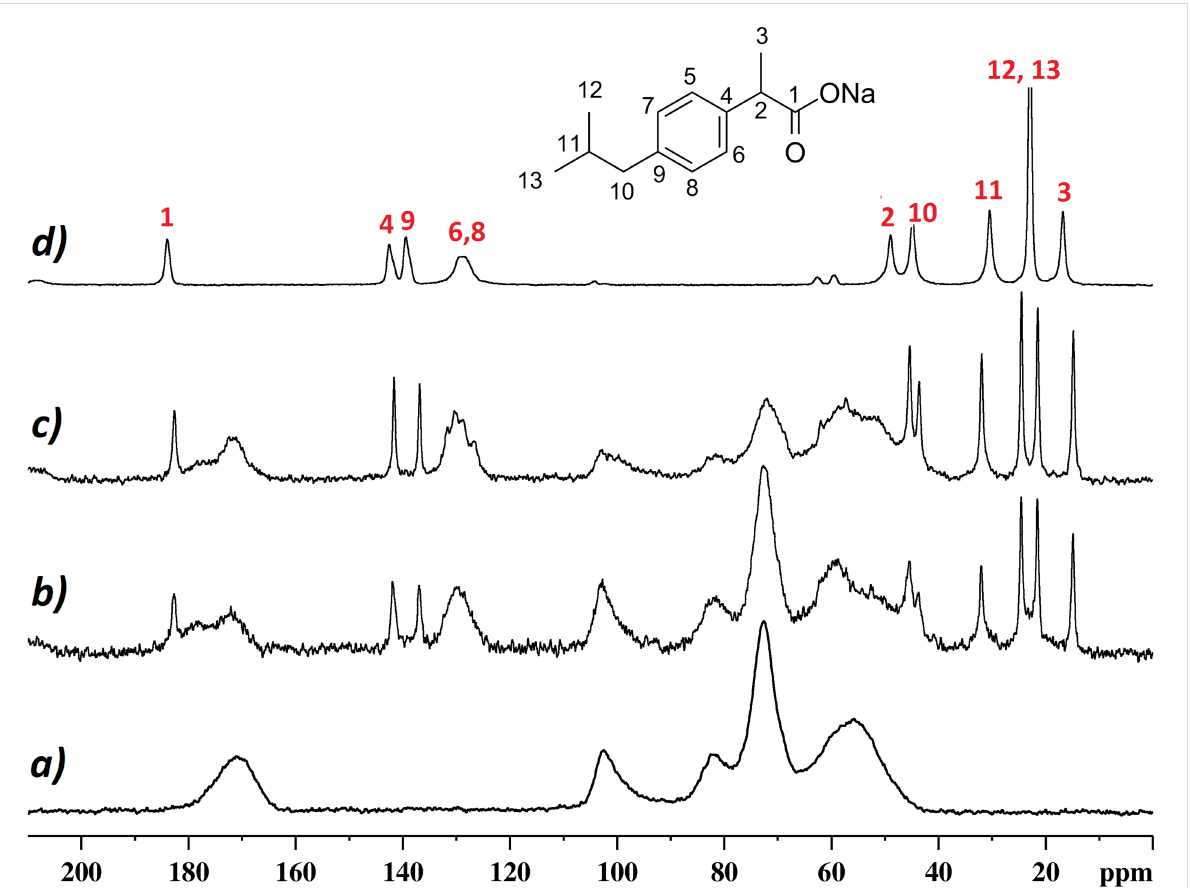
Figure 5: 13 C CP-MAS NMR spectrum of: a) CDNS(1:4) polymer; b) CDNS(1:4)-IbuNa system; c) CDNS(1:8)-IbuNa system; d) pure IbuNa (refer- ence spectrum). The molecular structure and atom numbering of IbuNa are shown in the inset. The notation CDNS-IbuNa indicates the original prepa- ration, irrespective of the conversion of the sodium salt into the undissociated acid.